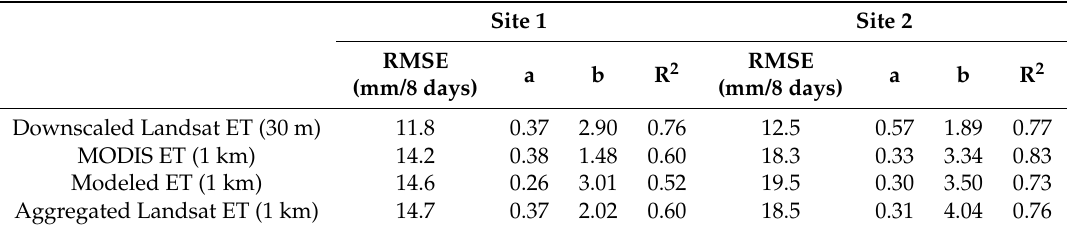
Table 6. Linear regression results between satellite-based ET and in situ ET at Sites 1 and